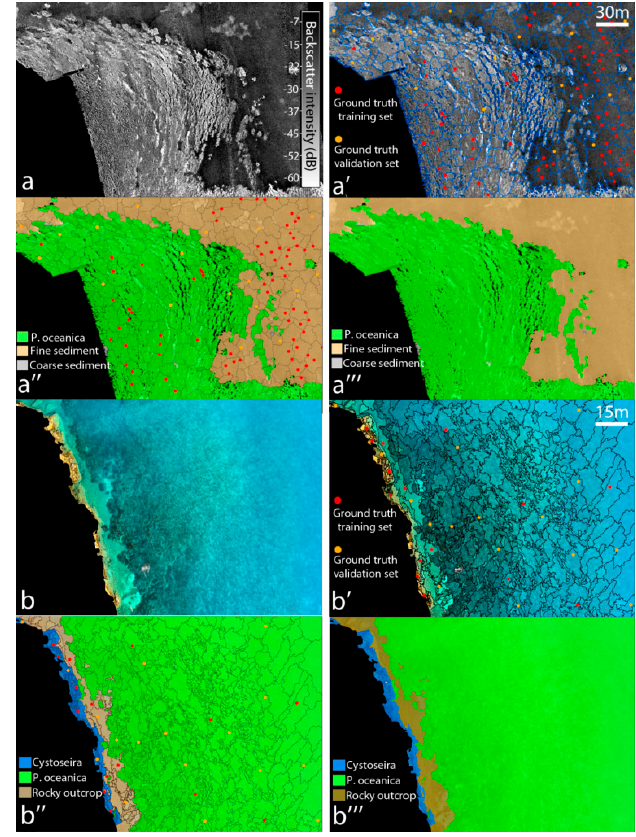
Figure 11. Shallow water classification process from multibeam data: ( a ) backscatter intensity map; ( a’ ) multiresolution segmented objects image and training and validation set; ( a’’ ) RT classified map: (green: P. oceanica , light brown: Fine sediment, gray: Coarse sediment); ( a’’’ ) RT final classified map after merging and smoothing objects. Very shallow water classification process from UAV aerial photogrammetry: ( b ) Orthomosaic UAV image; ( b’ ) Orthomosaic segmented into image objects and training and validation set; ( b’’ ) k-NN classified map: green: P. oceanica , blue: Cystoseira, pale brown: Rock); ( b’’’ ) k-NN final classified map after merging and smoothing objects. See Figure 10 for location.